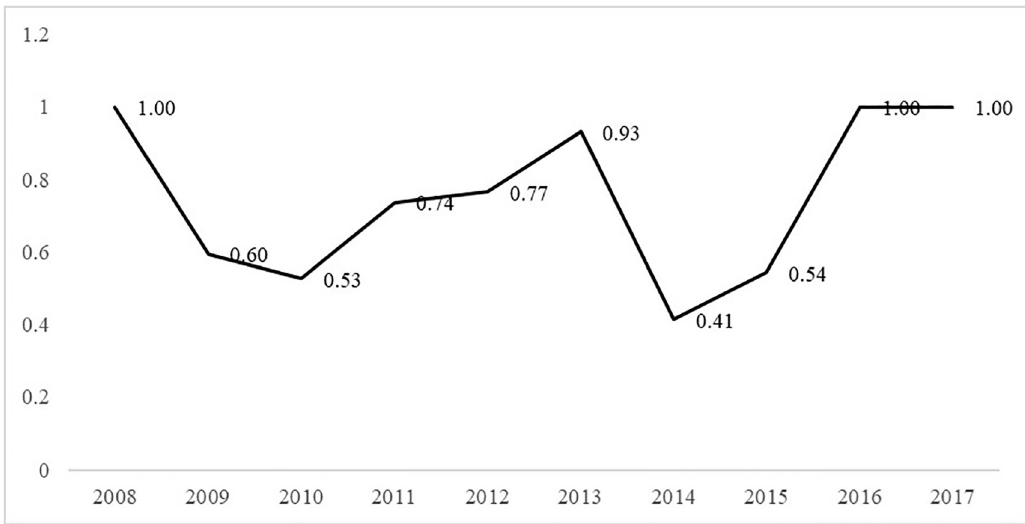
Fig 3. Connectedness of urban innovation in